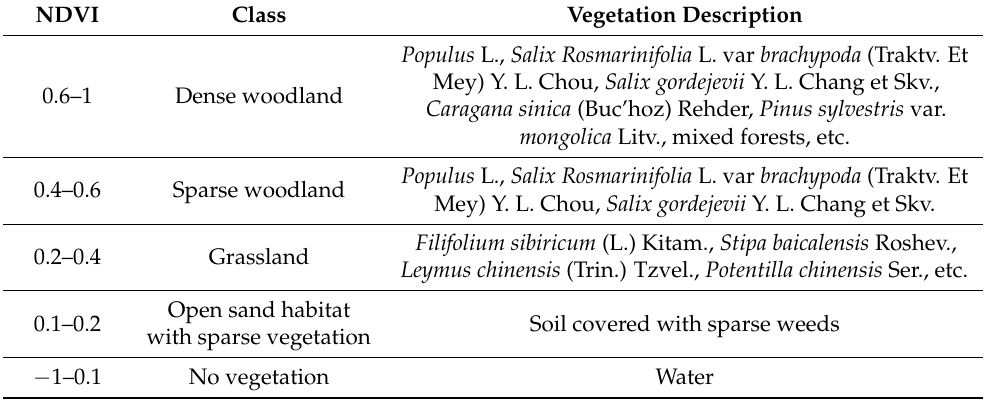
Figure 2. The vector diagram of dominant tree species in 2016 and the NDVI of the corresponding year (( A ) Survey data of typical tree species in 2016 provided by the forestry department; ( B ) NDVI distribution of typical tree species in 2016 calculated based on the survey data provided by the forestry department). Table 4. NDVI classification.